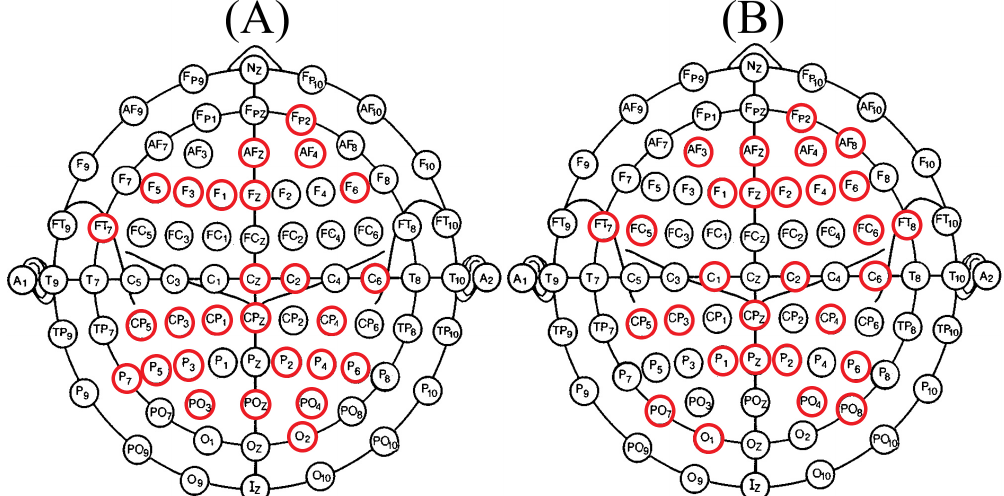
Figure A2. ( A ) EC. Union of EEG channels (27 in total) between HIGH and LOW stress-susceptible groups. These channels were FP2, AF4, AFZ, F5, F3, F1, Fz, F6, FT7, Cz, C2, C6, CP5, CP3, CP1, CPZ, CP4, P7, P5, P3, P2, P4, P6, PO3, POZ, PO4, O2. ( B ) EO. Union of EEG channels (29 in total) between HIGH and LOW stress-susceptible groups. These channels were FP2, AF3, AFZ, AF4, AF8, C1, C2, C6, CP5, CP3, CPZ, CP4, F1, FZ, F2, F4, F6, FT7, FC5, FC6, FT8, P1, PZ, P2, P6, PO7, PO4, PO8,